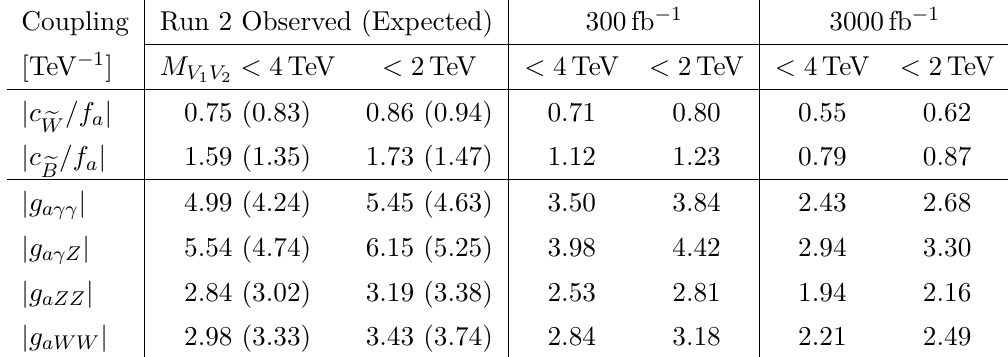
/f a and c /f a and e W e B √ s = 14 TeV and below 4 TeV or 2 TeV. 1 V 2 /f , c /f ) plane, namely a a e W e B